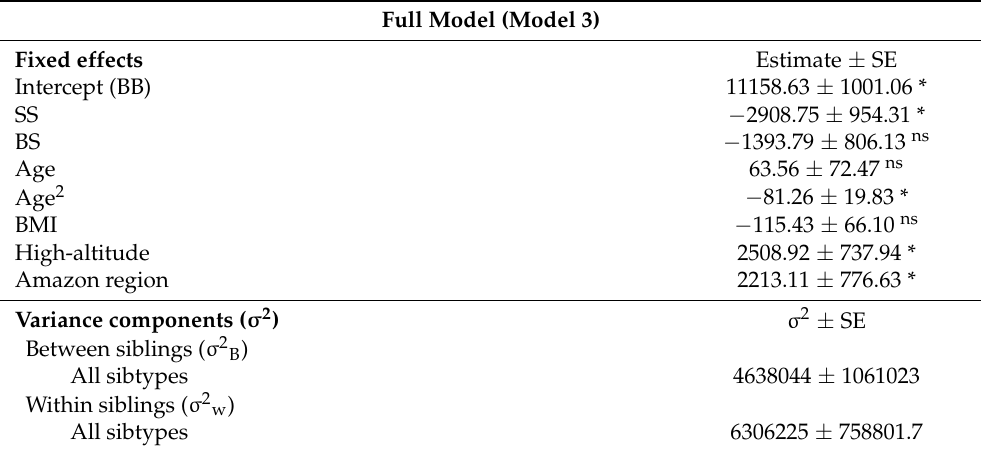
Table 3. Estimates, standard errors (SE), and variance components ( σ 2 ) for total number of steps · day − 1